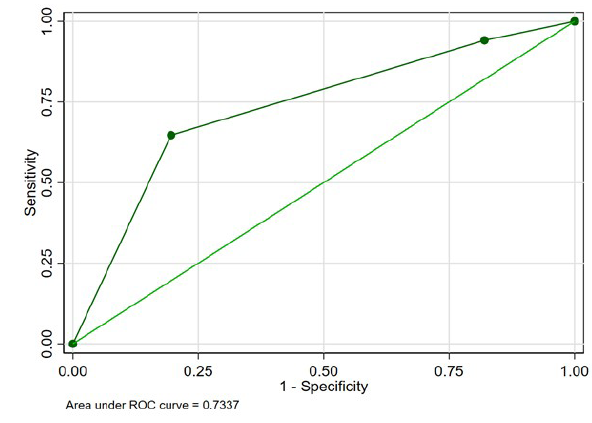
Fig. 3 - Receiver operating characteristic curve for the association between HAS-BLED score and